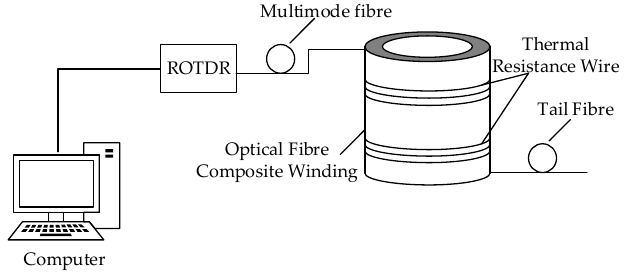
Figure 13. Temperature measurement system using optical fibre.